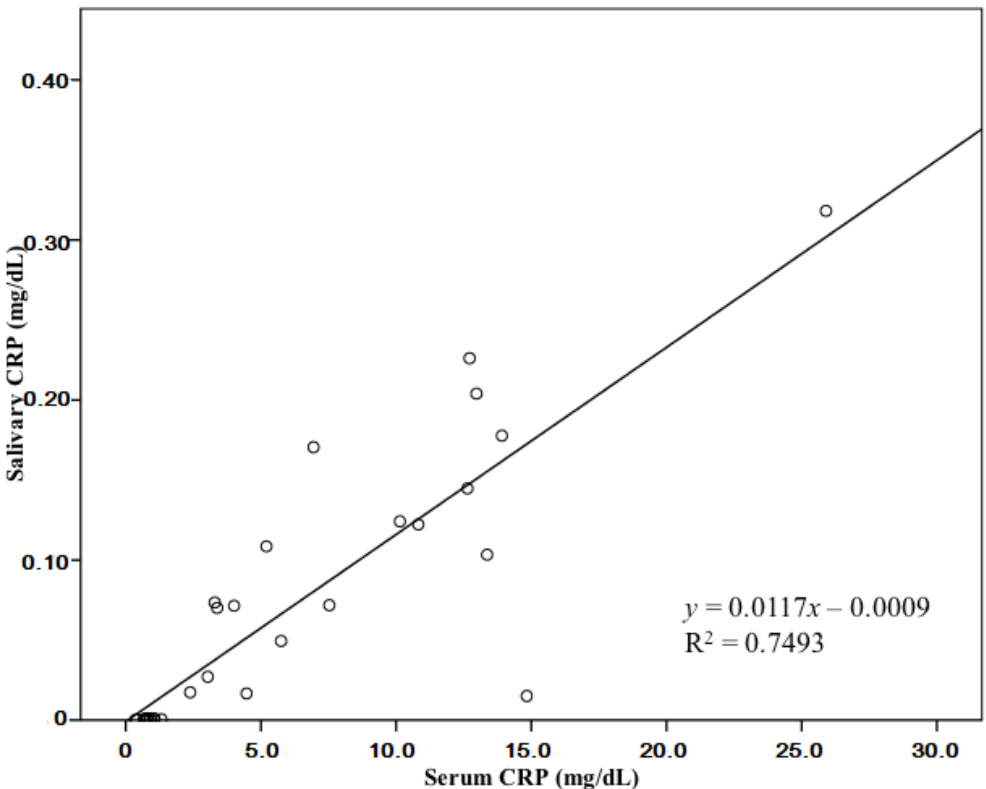
Table 2. Comparison of the signalment and median CRP levels of the inflammation group and non- inflammation group.